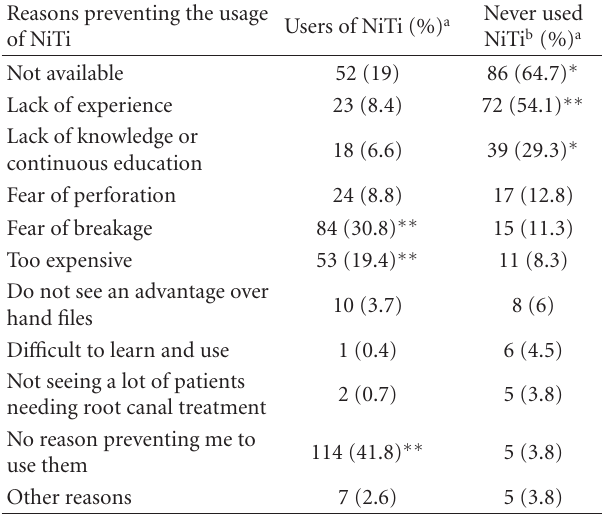
Table 8: Reasons preventing the usage of